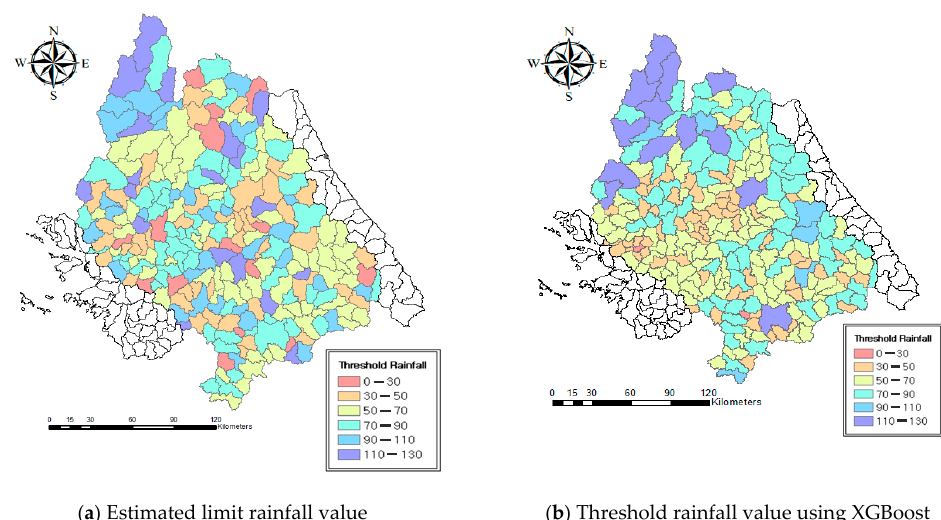
Figure 11. Comparison of training data against actual values.